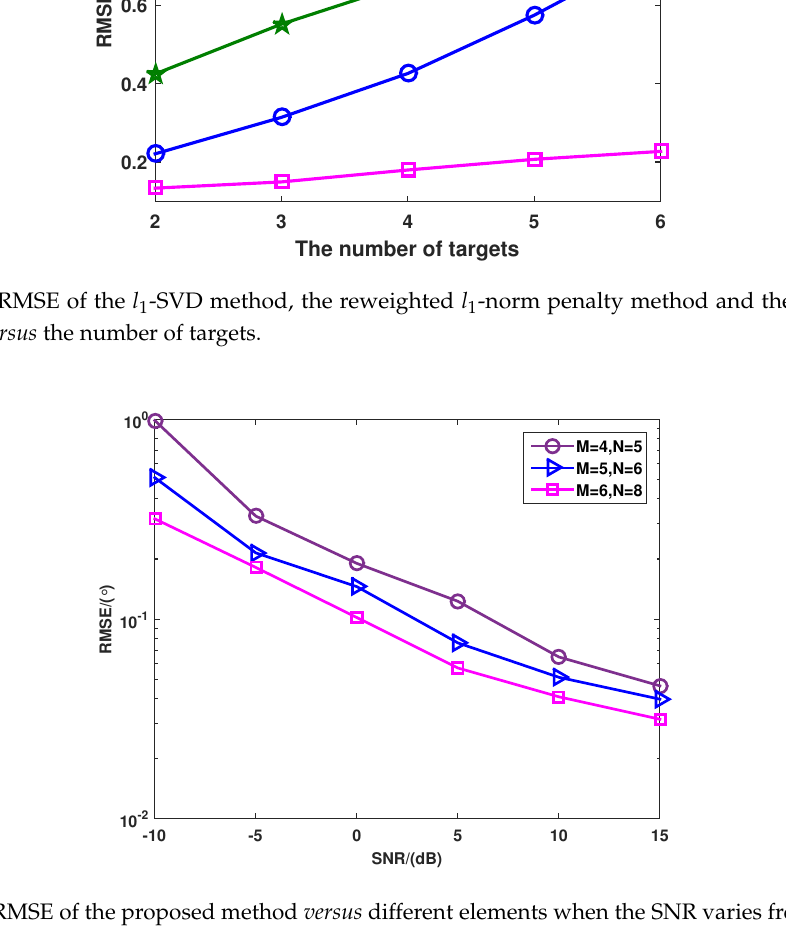
Figure 7. RMSE of the proposed method versus different elements when the SNR varies from − 10 dB to 15